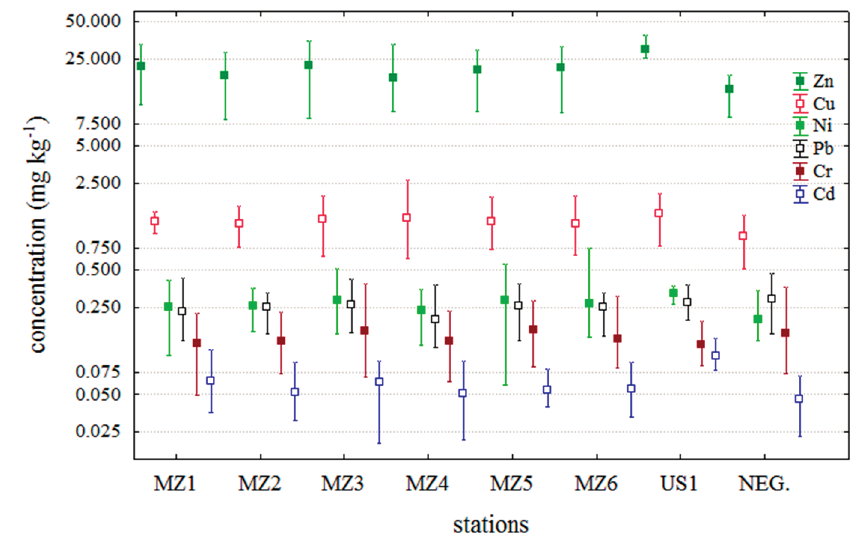
Figure 1. Metal concentration in studied blue mussels. NEG–DSP negative mussels samples; other samples are DSP